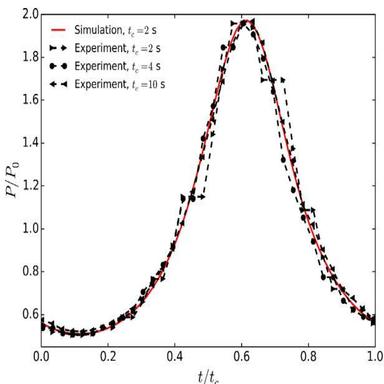
Experimental and simulated dimensionless pressure profile for He runs in the packed bed with different cycle times. Conditions: T0 = 30 C; u ¼ 0:5p; Stroke1 = Stroke2 = 0–100 mm.